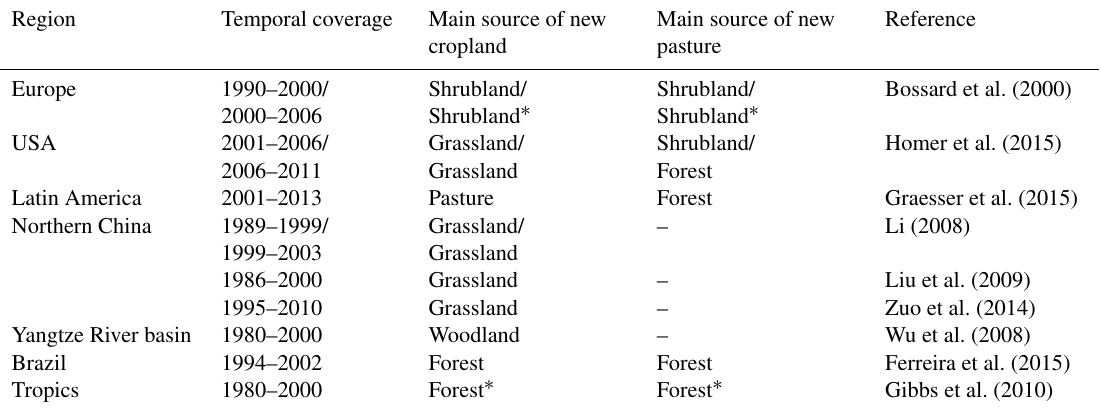
Figure 4. Sources of agricultural land (cropland and pasture combined) for two time periods in Europe based on the CORINE land-cover data (a) and sources of cropland and pasture for two time periods in the USA based on the NLCD land-cover data (b) (Supplement Sect. S2.3, Table S3). Changes between different agricultural classes are not considered as expansion of agricultural land. Aggregation of CORINE and NLCD legends to forest, grassland, and shrubland is according to Tables S4–5. The category “other” includes urban land, wetlands, water, and bare land. Table 2. Case studies and continental-scale remote sensing studies that report main sources of agricultural expansion or allow for land-cover change